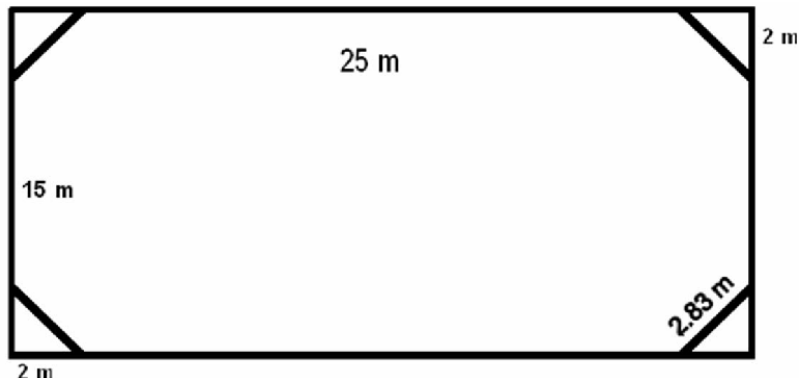
Figura 1. Circuito delimitado em quadra para a realização do teste de potência